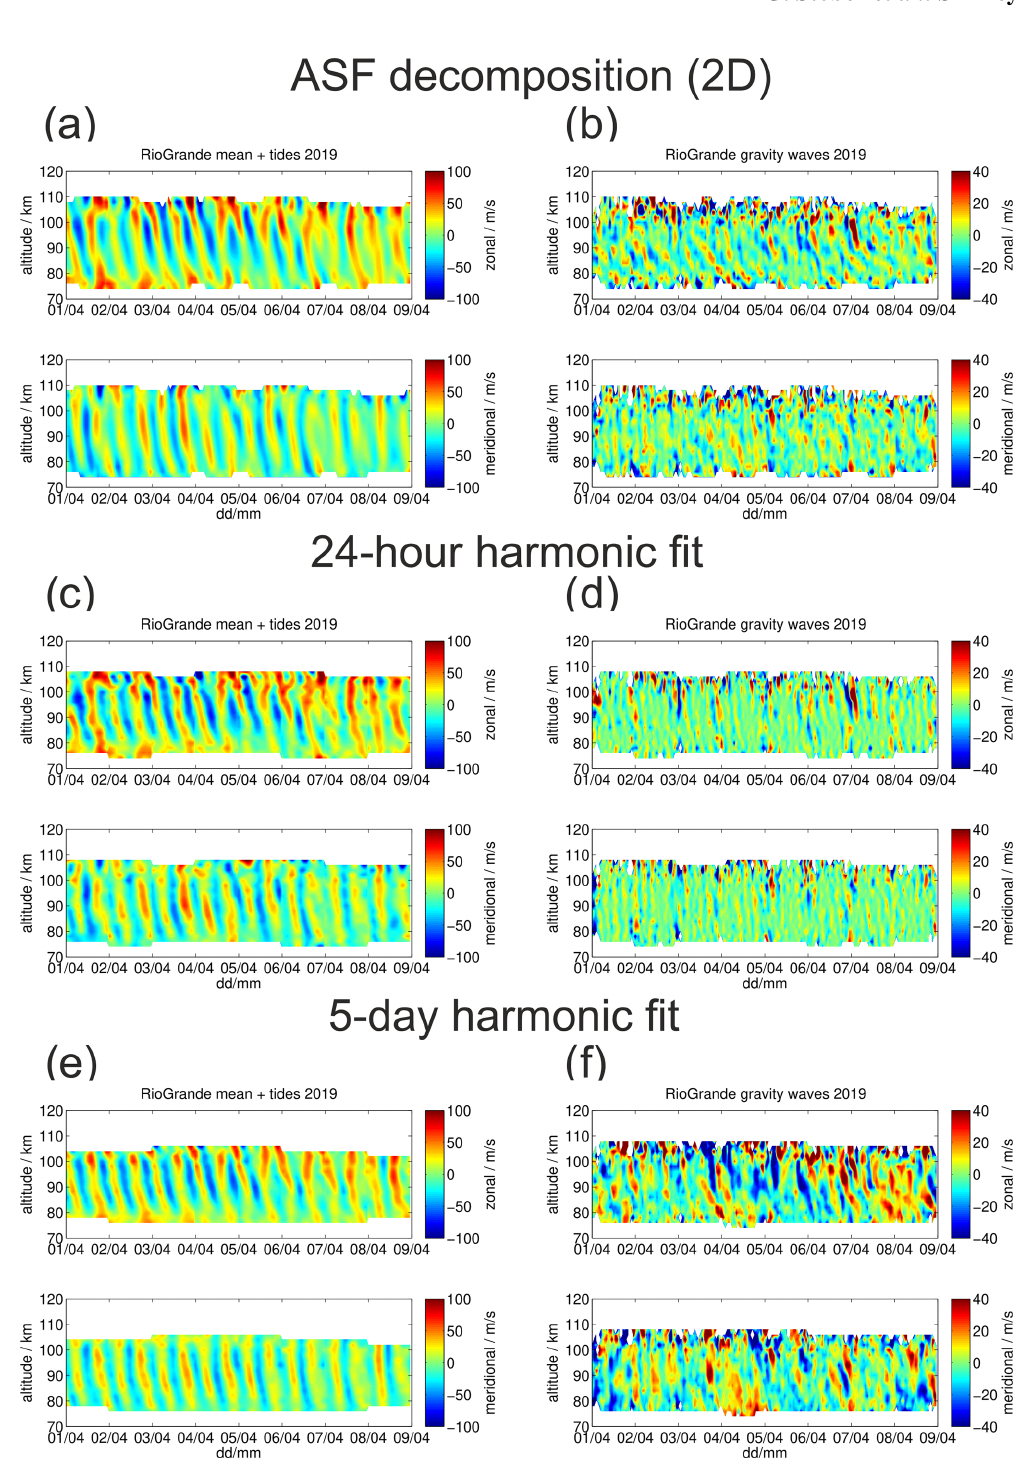
Figure A3. Comparison of different Reynolds decomposition for 8d at TDF (Rio Grande) to underline the sensitivity of the applied method in deriving gravity wave fluctuations. Panel (a) shows the ASF reconstructed daily mean plus diurnal, semidiurnal and terdi- urnal tide time series. Panel (b) presents the gravity wave residuals. Panels (c) and (d) show the same but for a 24h harmonic fit and panels (e) and (f) for a 5d harmonic